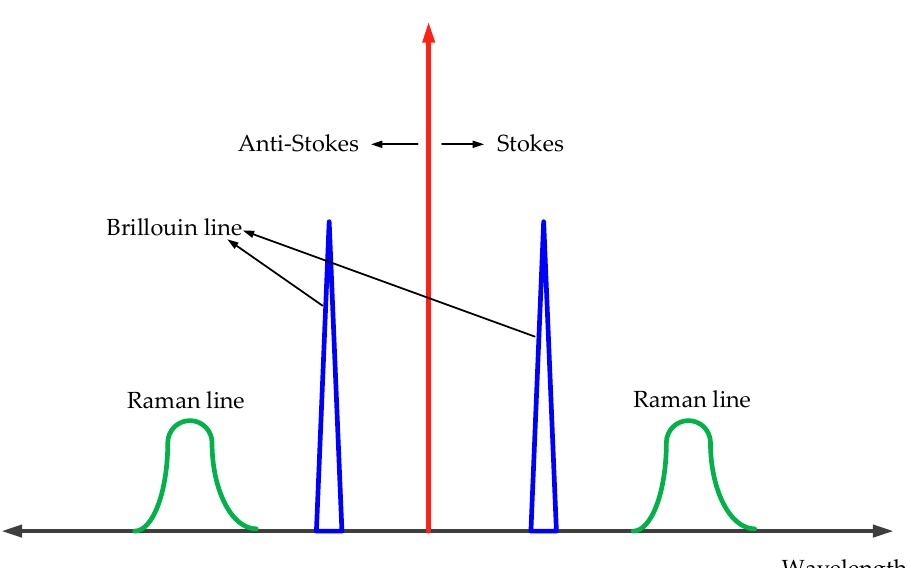
Figure 1. Scattering spectrogram in optical fiber.